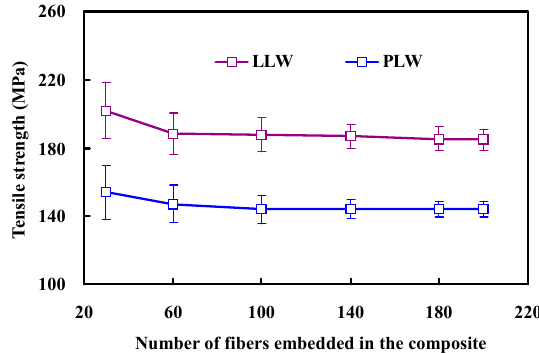
Figure 1. Dependence of tensile strength on the composite size.